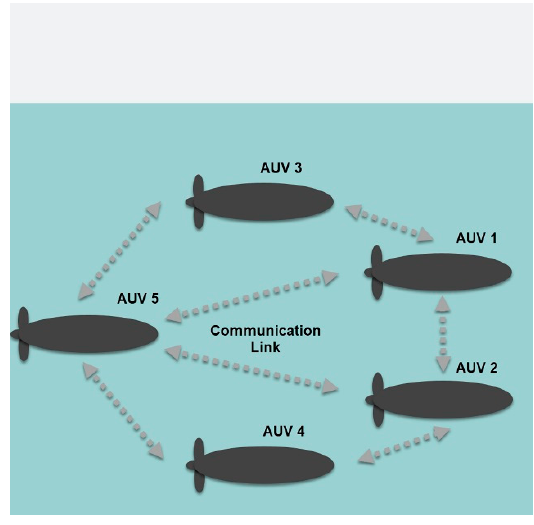
Figure 15. Parallel navigation of AUVs.